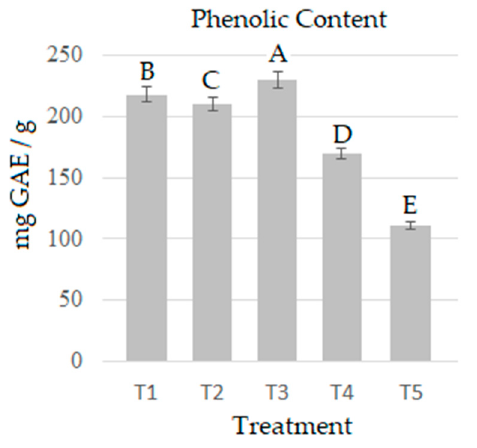
Figure 2. Phenolic content in P. djamor over the five treatments. The bars indicate the mean of each treatment in triplicate with SE. Different letters indicate significant difference (T-Student p ≤ 0.05).